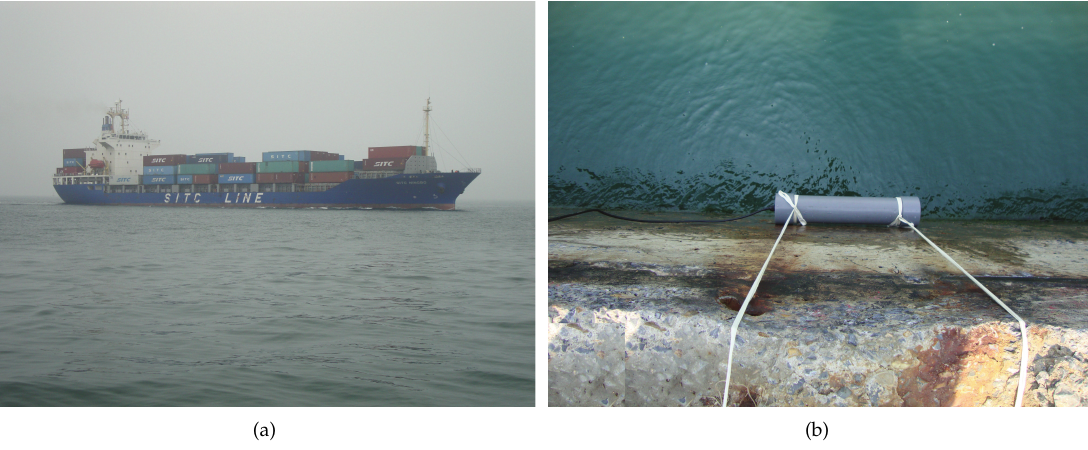
Figure 2. The detection experiment on a shallow sea. ( a ) the surface ship as the target; ( b ) the magnetic field sensor above the sea